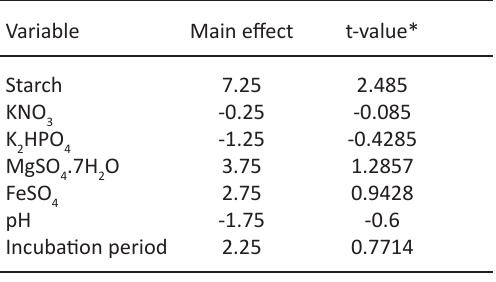
Table 4. Statistical analyses of the Plackett-Burman